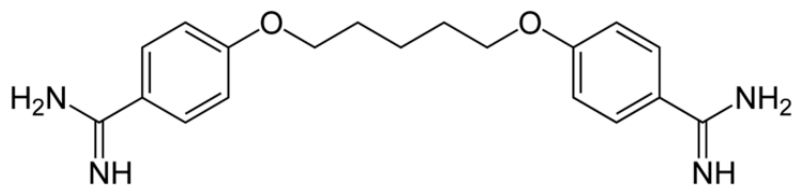
Figure 1. Chemical structure of pentamidine (1,5-bis(4-amidinophenoxy)pentane).